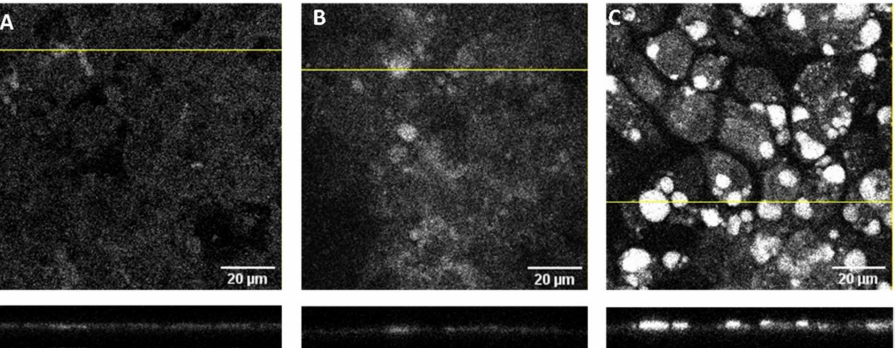
Figure 7. Confocal microscopy images of Caco-2 monolayers obtained with excitation light at 405 nm and emission detection from 408–490 nm. Representative optical section images along the z -axis (1 µ m) are shown for ( A ) cell monolayers in the insert not used for any permeability assay and for cell monolayers exposed to DHE 100 µ M ( B ) and both DHE 100 µ M and coffee D1 ( C ) during a permeability assay of 6h. The lower insets show the localization of the fluorescence in the cross section of a z-x plane corresponding to the position of the yellow